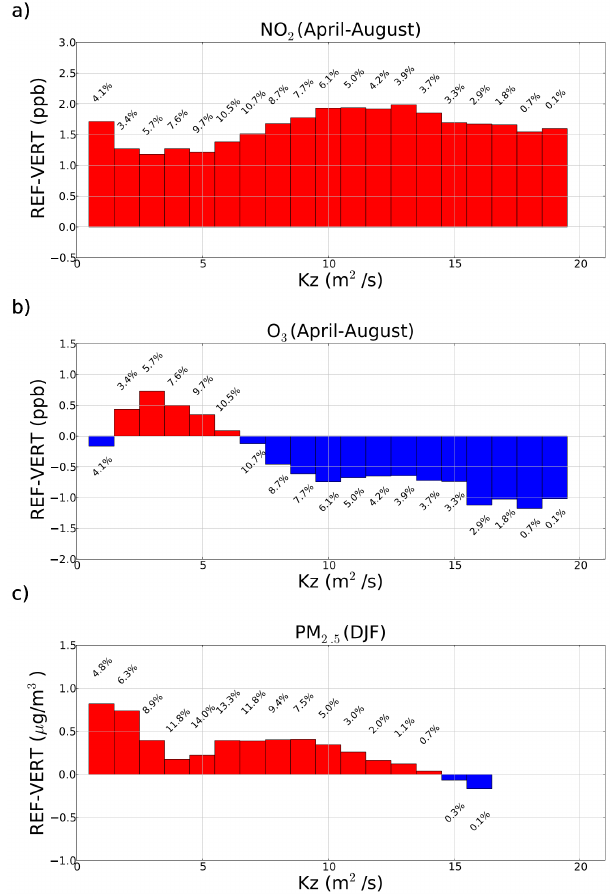
Figure 7. Difference in average daily simulated NO 2 (a) , ozone (b) and PM 2 . 5 (c) concentrations between VERT (12 vertical layers) and REF (8 vertical layers) at urban areas per range of K z (bins of 1m 2 s − 1 ). Positive differences indicate that the refined vertical mesh leads to increased pollutant concentration and vice versa. The occurrence of sensitivity values within each K z range is also pro-